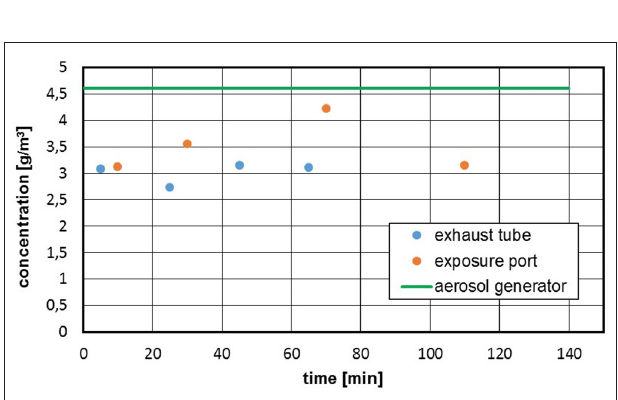
FIGURE 7 | Untreated pyrogenic silica, c m = 4,700 mg/m 3 , gravimetric mass concentration after different run times; green line: at the aerosol generator.